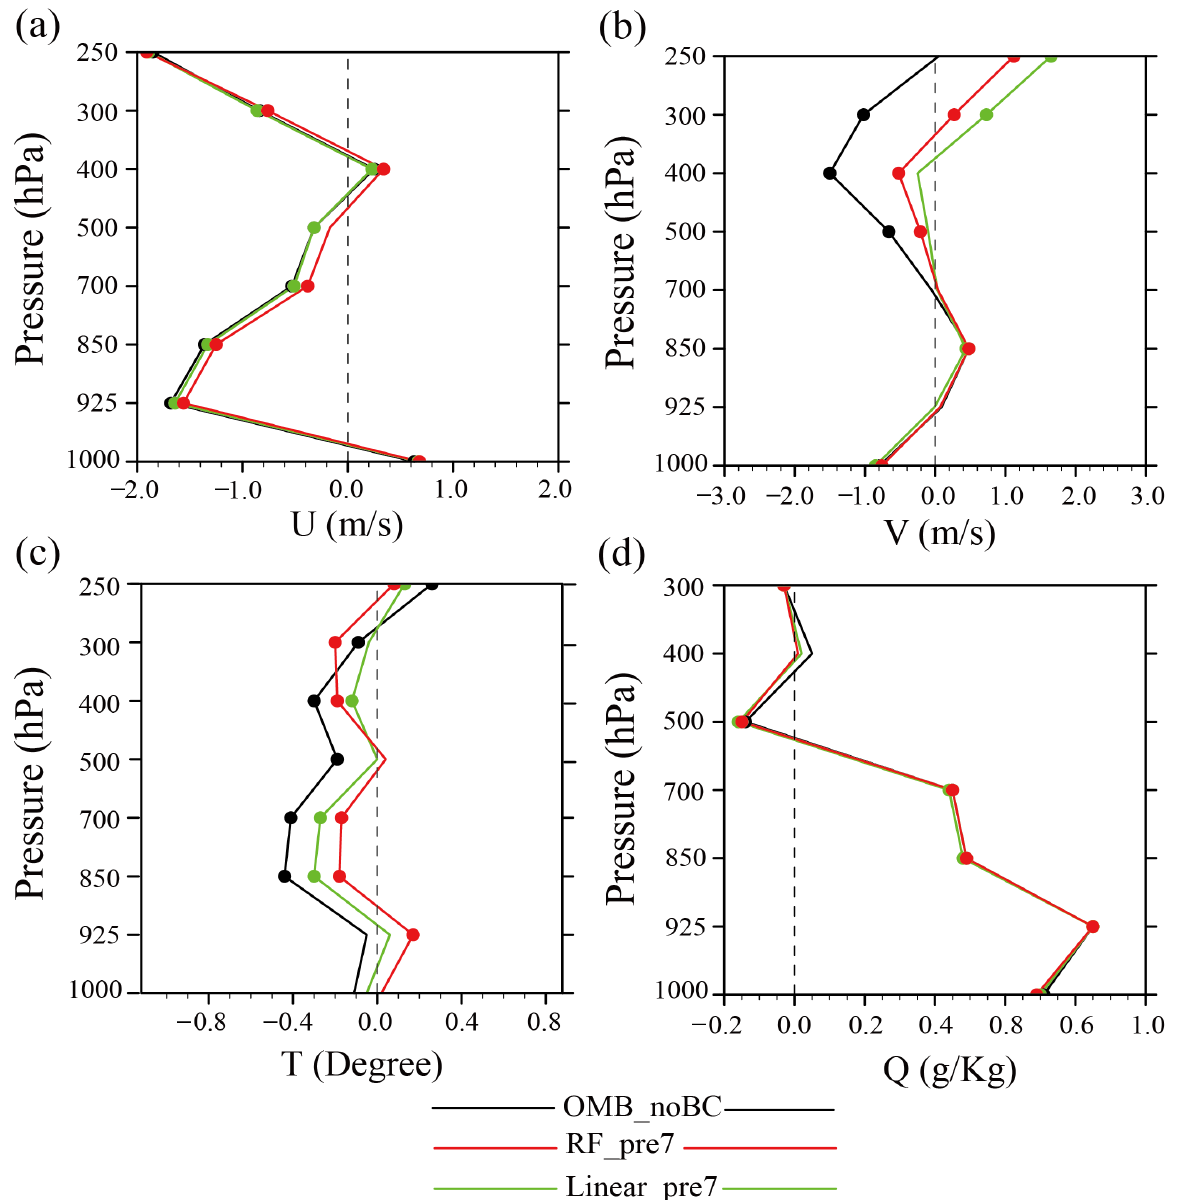
Figure 10. The bias vertical profiles of the analyses with the radiances of AGRI channels 9–10 from the OMB_noBC (black lines), RF_pre7 (red lines), and Linear_pre7 (green lines) experiments, respec- tively, verified against the sounding and surface synoptic observations for ( a ) U-wind, ( b ) V-wind, ( c ) temperature, and ( d ) specific humidity valid at 0600 UTC 19 July 2021. The marked dots show a significance level above 95%.